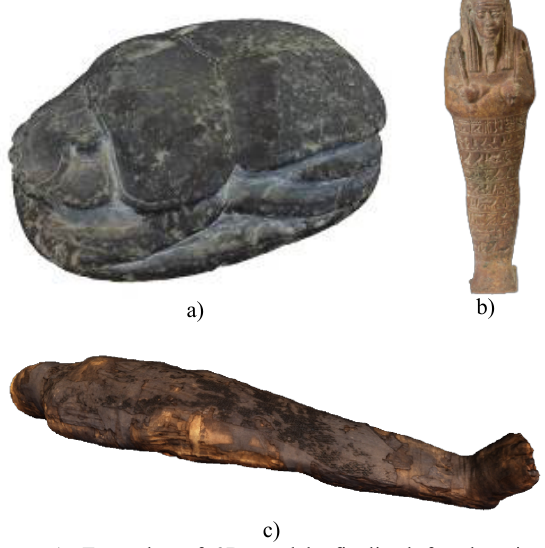
Figure 1. Examples of 3D models finalized for the virtual environment: a) the Scarab of the heart; b) ushabti